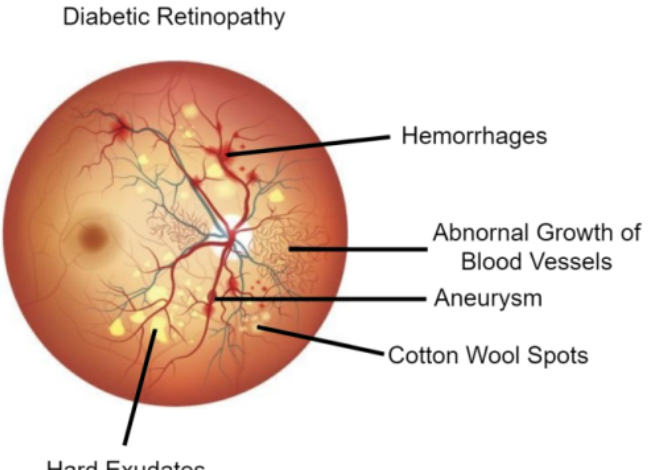
Figure 1. Diabetic Retinopathy Lesions [2].